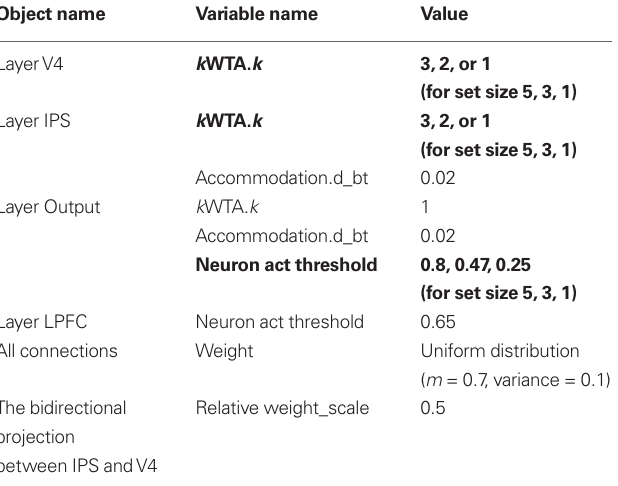
Table 1 | Model settings (all variable settings remain fixed in all experimental conditions except those shown in